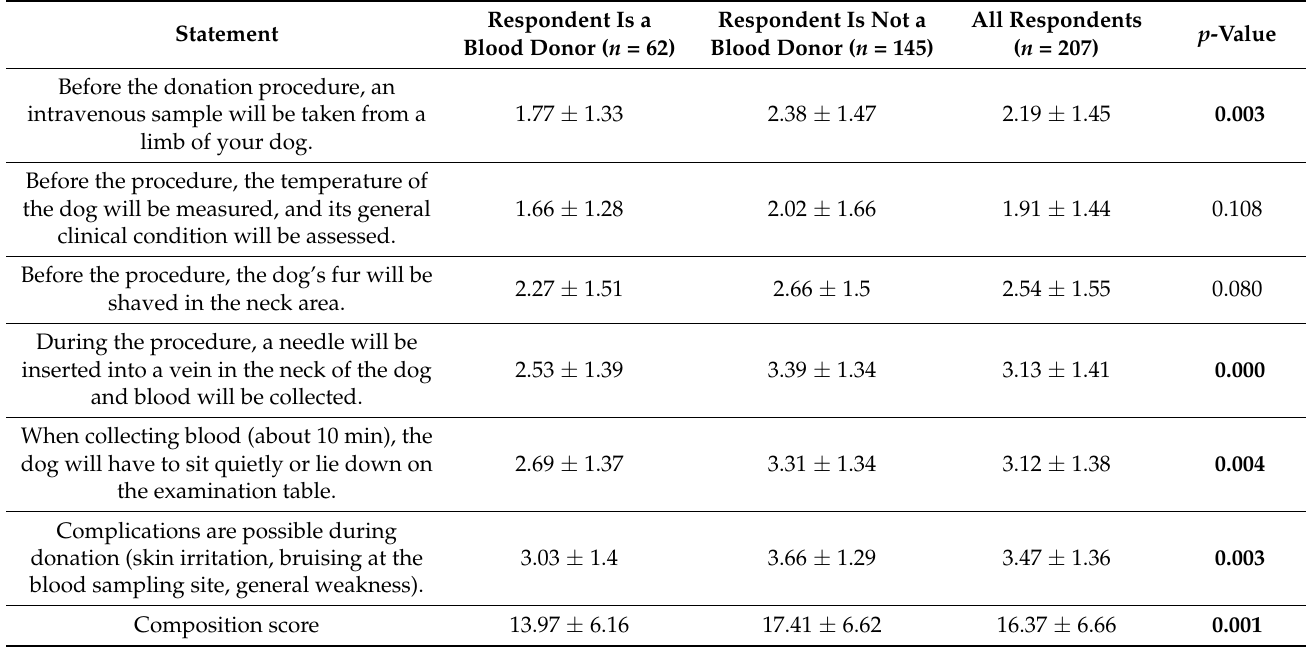
Table 2. The association between the statements from the survey about fear towards the canine blood donation procedure and the respondent being a human blood donor himself/herself. The values present the means ± standard deviation. Significant p -values are highlighted in